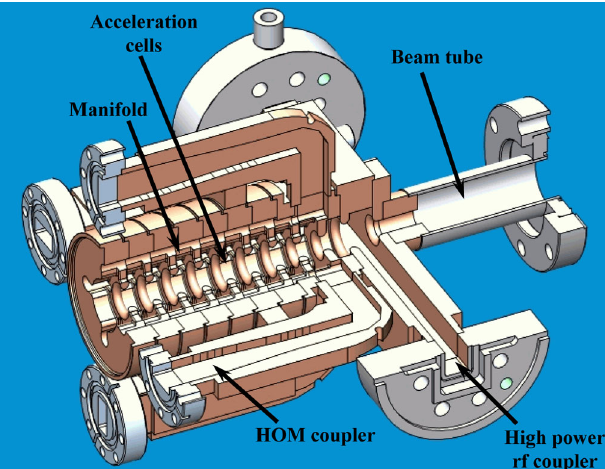
FIG. 6. (Color) CAD drawing illustrating a cross-sectional view of the output region of